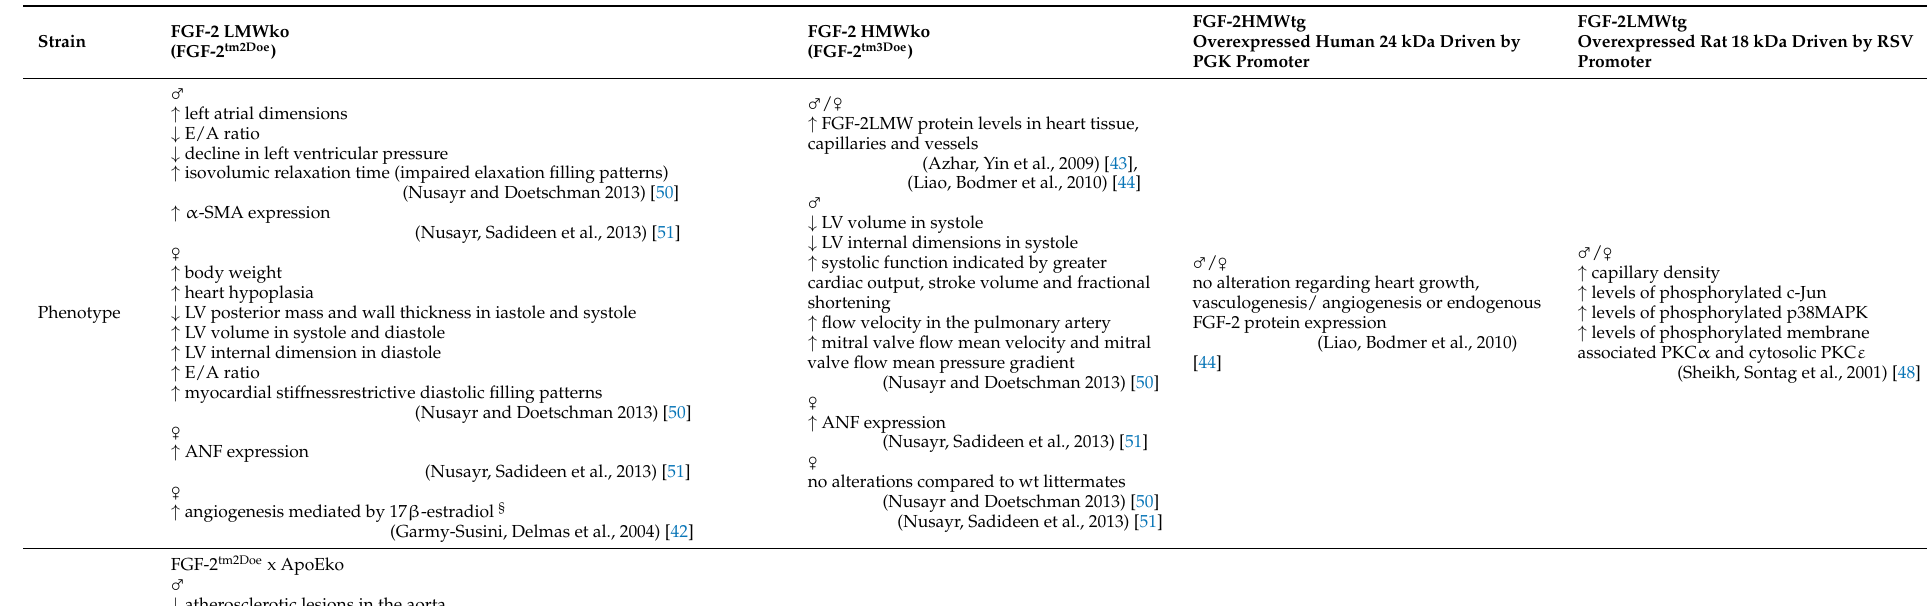
Table 1. Characterization of the cardiovascular system of male ( ) and female ( ) FGF-2 isoform-specific mouse mutants through development. Alterations were provided as increased ( ↑ ) ♀ ♂ or decreased ( ↓ ) compared to wildtype littermates for either FGF-2 isoform-specific ko mice (FGF-2LMWko and FGF-2HMWko), or mice additionally overexpressing rat FGF-2LMW (FGF-2LMWtg) or human 24 kDa FGF-2HMW (FGF-2HMWtg). To increase understandability, findings were separated by sex whenever possible and mentioned at their first description. The FGF-2 isoform-specific cardioprotective potential was evaluated in different disease models summarized in Supplemental Table S1. α -SMA, α -smooth-muscle actin; ANF, atrial natriuretic factor; ApoE, apolipoprotein E; E/A ratio, early wave to atrial wave ratio; FGF-2, fibroblast growth factor 2; HMW, high molecular weight; JNK, c-Jun N-terminal kinase; ko, knock out; LWW, low molecular weight; LV, left ventricular; MAPK, mitogen activated protein kinase; MCP-1, monocyte chemoattractant protein-1; Nox4, NADPH oxidase 4; PGK, phosphoglycerate kinase; PKC, protein kinase C; RSV, Rous sarcoma virus long terminal repeat; tg, transgene; VCAM-1, vascular cell adhesion protein 1; § compared to